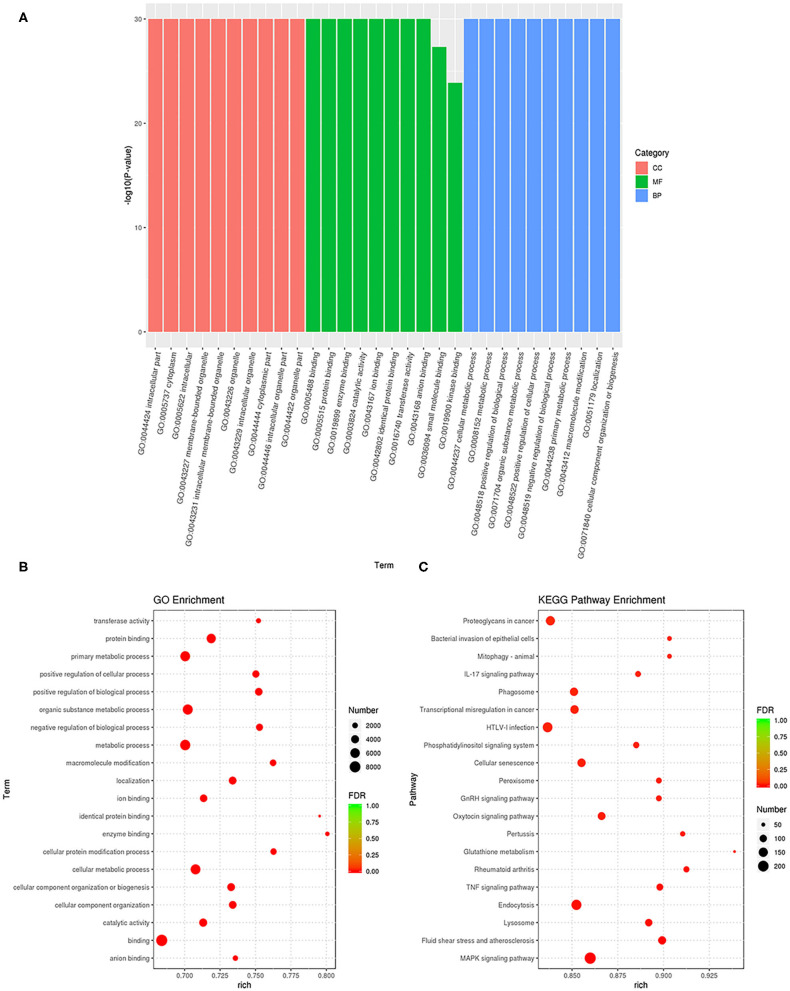
Functional annotation and enrichment analysis of differentially expressed miRNAs. (A) The results of Gene Ontology (GO) enrichment analysis of differentially expressed GO classified miRNA target genes according to molecular functional (MF), biological process (BP), and cellular component (CC) analysis, and the top 10 GO term items with the smallest P-value or the most significant enrichment were selected for display in each GO classification. The X-axis represents gene function, and the Y-axis represents gene percentage. (B) Scatter diagram of GO enrichment analysis of differentially expressed target genes of miRNA. (C) Scatter diagram of Kyoto Encyclopedia of Genes and Genomes (KEGG) pathway enrichment analysis of differentially expressed target genes of miRNA. The ratio of the number of differential miRNA target genes enriched in the pathway to the number of annotated differential miRNA target genes.